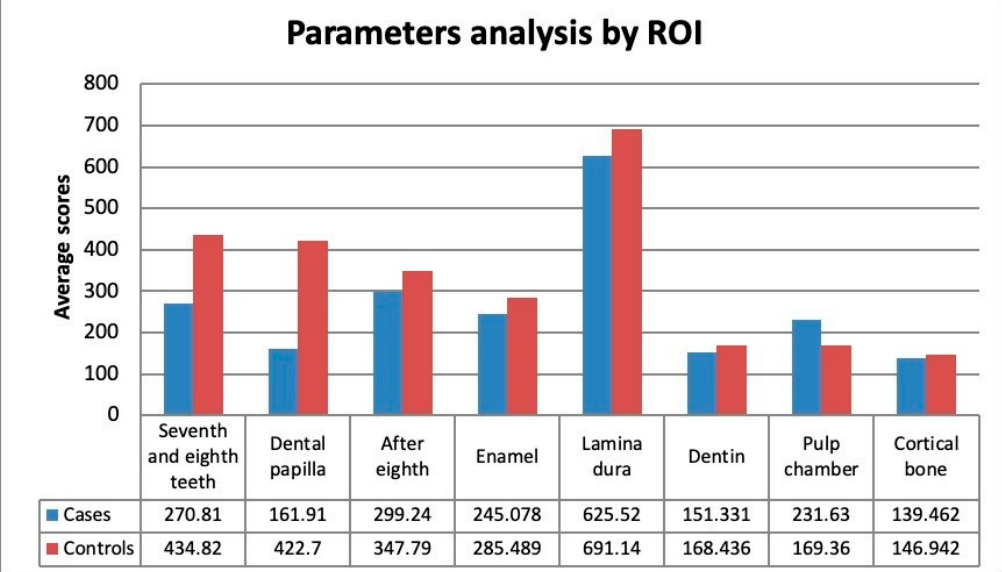
Figure 3. Parameters analysis by ROI. Scores of enamels, lamina dura, dentin and cortical bone are divided by 10 to preserve graph proportions.